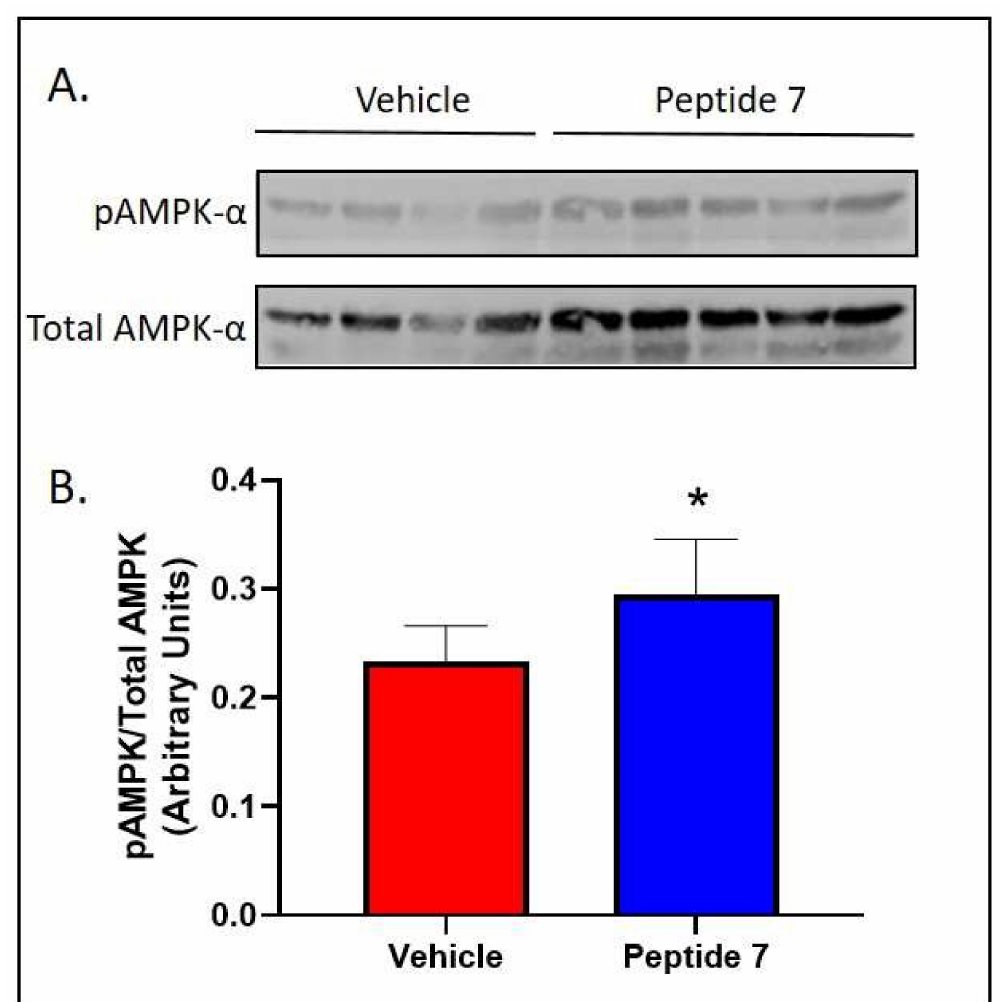
Figure 5. Peptide 7 administration increased fatty acid oxidation signalling in the liver. Mice were fed a HFD and treated with Peptide 7 for 2 weeks. Western blots for phospho-AMPK and Total AMPK are shown ( A ). Quantification of phospho-AMPK/Total AMPK ratio ( B ). n = 4–5/group. Mean ± SD. * p =